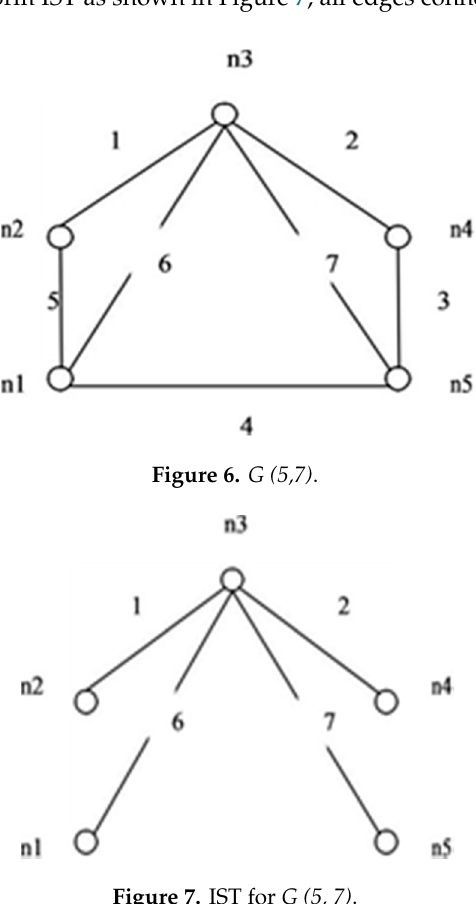
Table 1. Generation of successful spanning trees